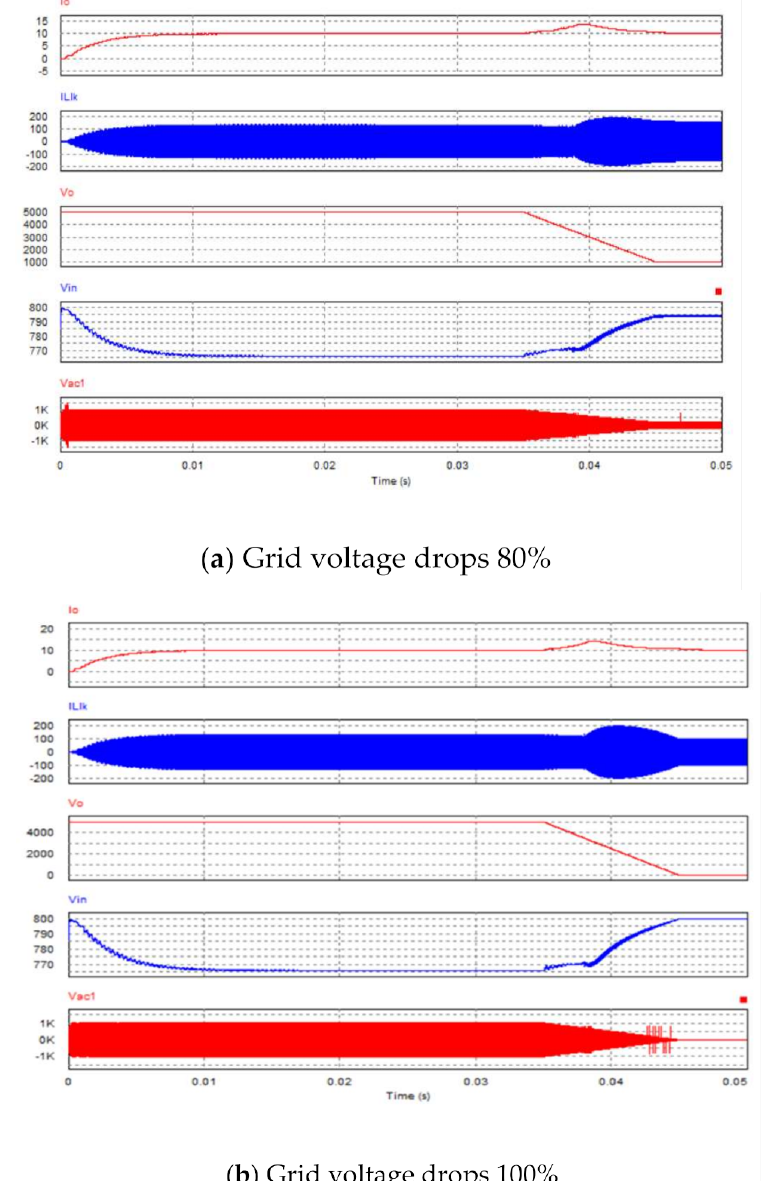
Figure 27. Simulation result of the process of